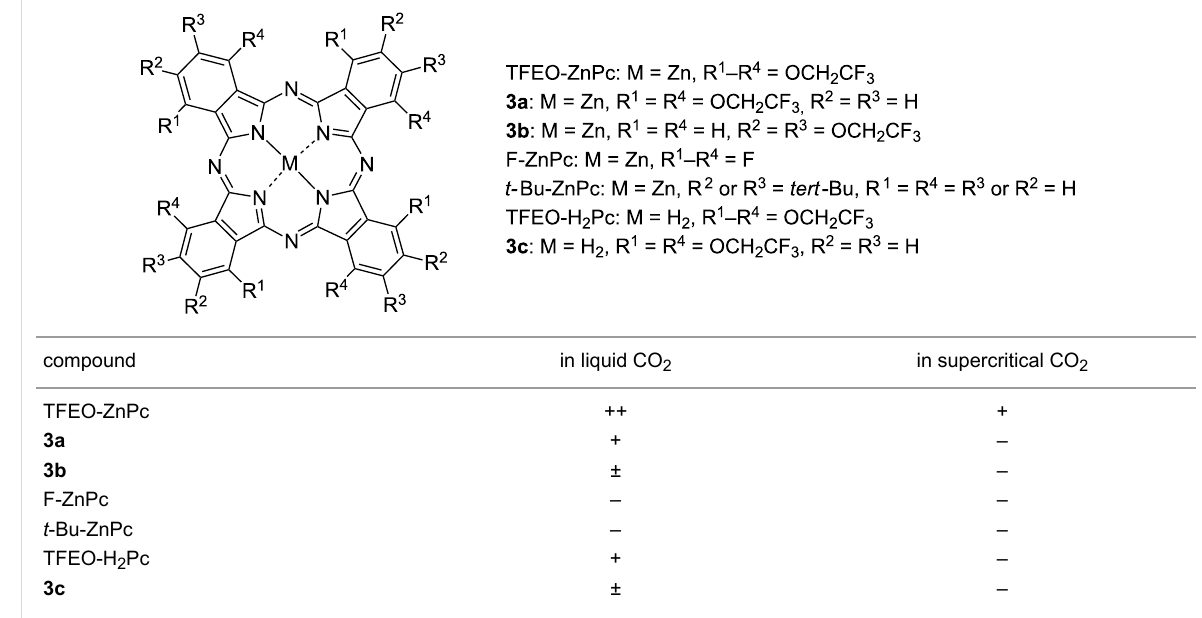
Table 1: Solubility of phthalocyanines in liquid CO 2 and supercritical CO 2 .